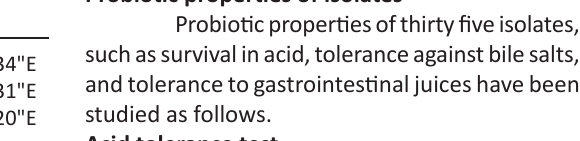
Table 1. Coordinations of sampling stations Sampling Latitude